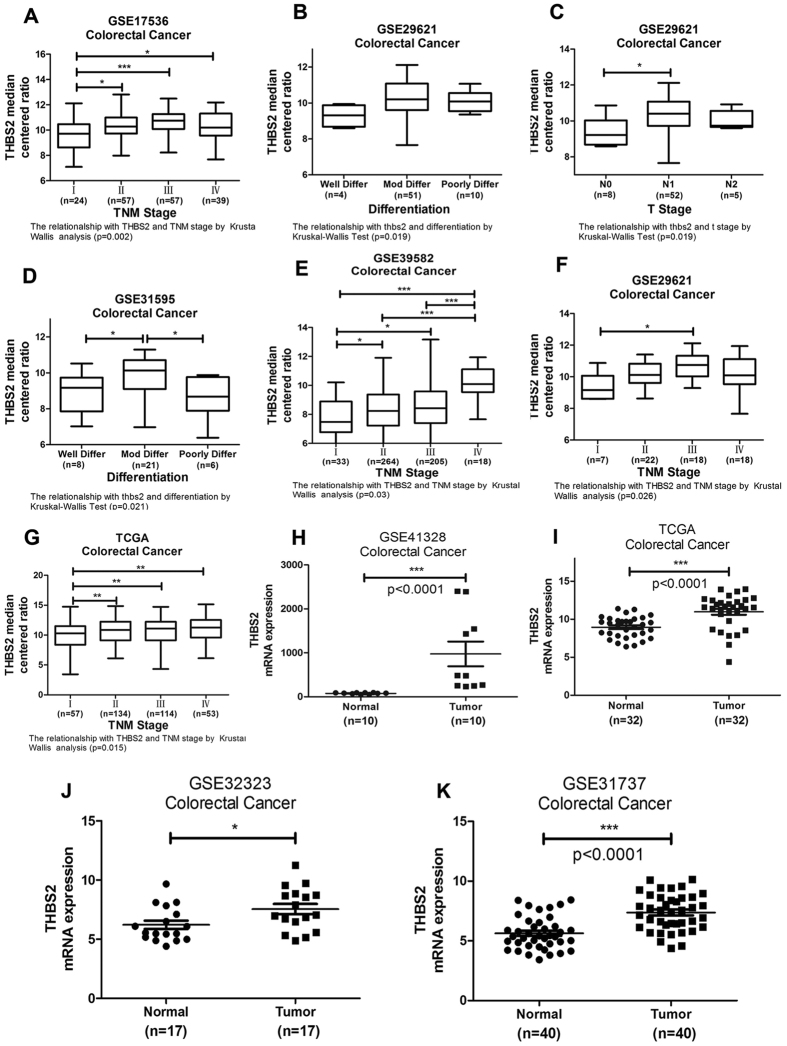
THBS2 was significant correlation with clinicopathology parameters in GEO datasets.(A) Krustal-Wallis Test confirmed that the THBS2 was correlation with TNM stage and differentiation. GSE17536, TNM stage, p = 0.002; (B) GSE29621, differentiation, p = 0.019; (C) GSE29621, T stage, p = 0.019; (D) GSE31595, differentiation, p = 0.021; (E) GSE39582, TNM stage, p = 0.030; (F) GSE29621, TNM stage, p = 0.026 (G) TCGA, TNM stage, p = 0.015; (H) GSE41328 showed that THBS2 was higher expression in tumor tissue when compared with paired adjacent normal tissue (p < 0.001); (I) TCGA showed that THBS2 was higher expression in tumor tissue when compared with paired adjacent normal tissue (p < 0.001); (J) GSE32323 showed that THBS2 was higher expression in tumor tissue when compared with paired adjacent normal tissue (p = 0.05); (K) GSE31737 showed that THBS2 was higher expression in tumor tissue when compared with paired adjacent normal tissue (p < 0.001).